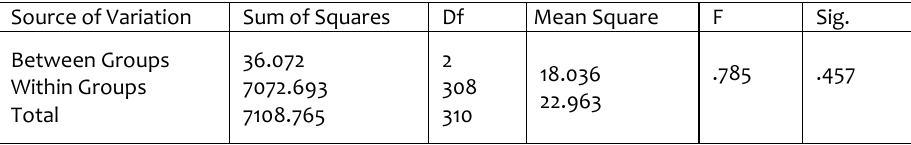
Table 5. Results of One Way ANOVA for Comparison of the Instructors’ Contribution to the Trainees’ Experiential Learning across CGPA (N=